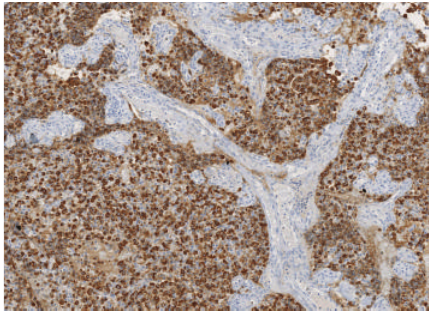
Figure 3: Chromogranin stain of tissue removed from left naso- pharynx at 20x confirming neuroendocrine origin of tissue.